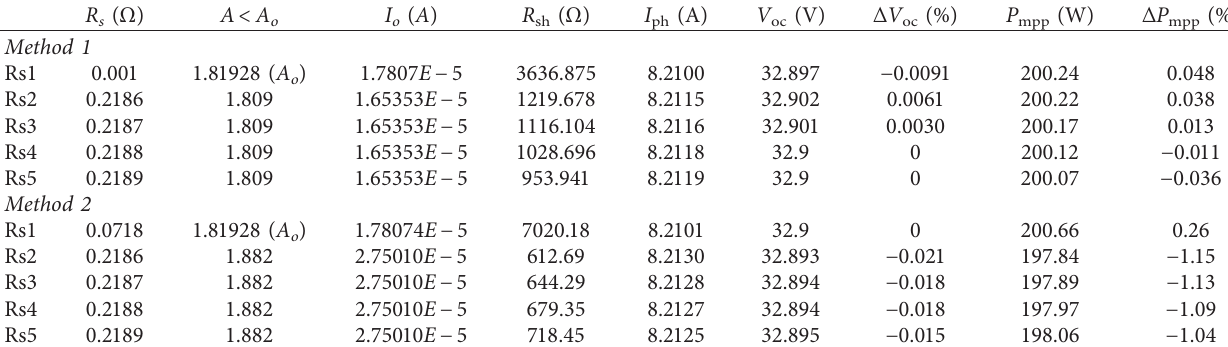
Table 3: Extracted parameters and data from simulations for Kyocera KC200GT.